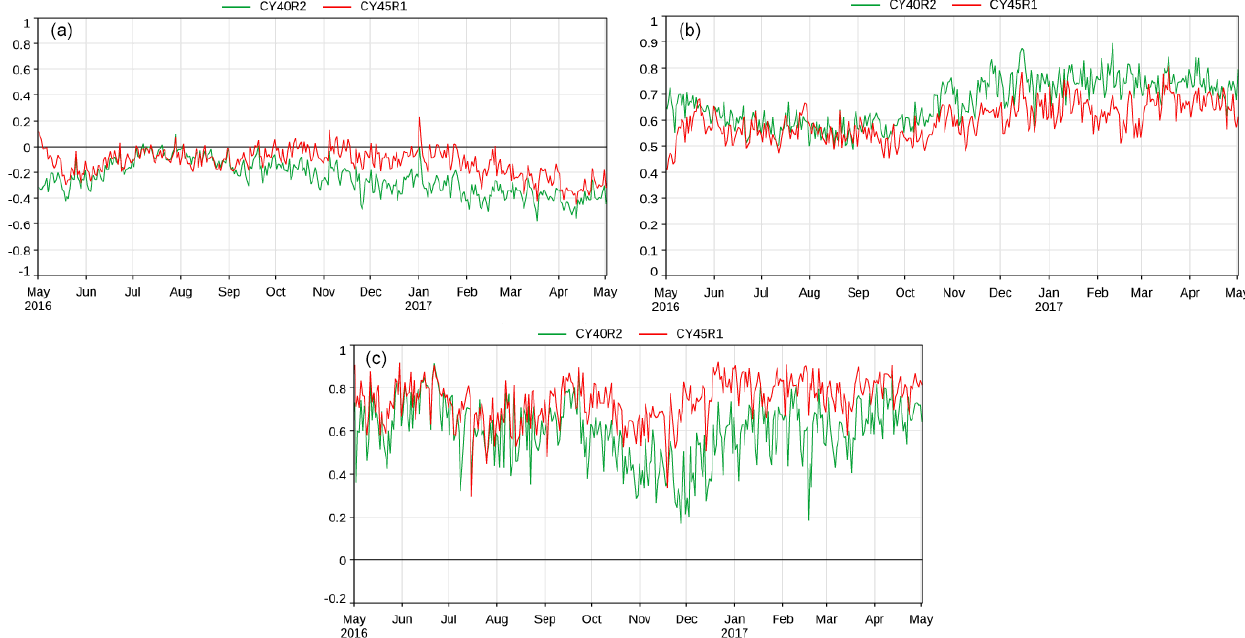
Figure 14. MNMB (a) , FGE (b) , and spatial correlation (c) of daily AOD at 500–550nm simulated by cycles 40R2 (green) and 45R1 (red) against global observations from